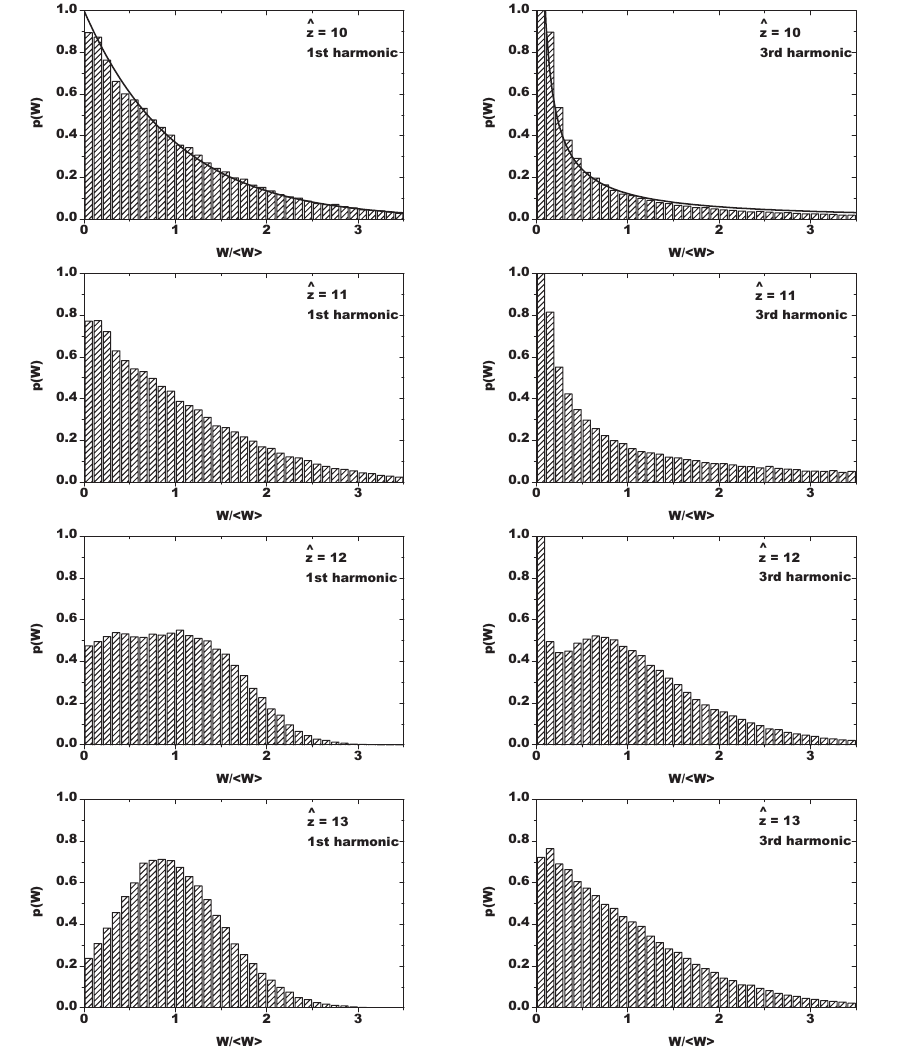
FIG. 7. Probability distribution of instantaneous radiation power at different lengths of the FEL amplifier ^ z (cid:3) 10 – 13 . Left and right columns correspond to the fundamental and 3rd harmonic, respectively. Solid line shows probability density function